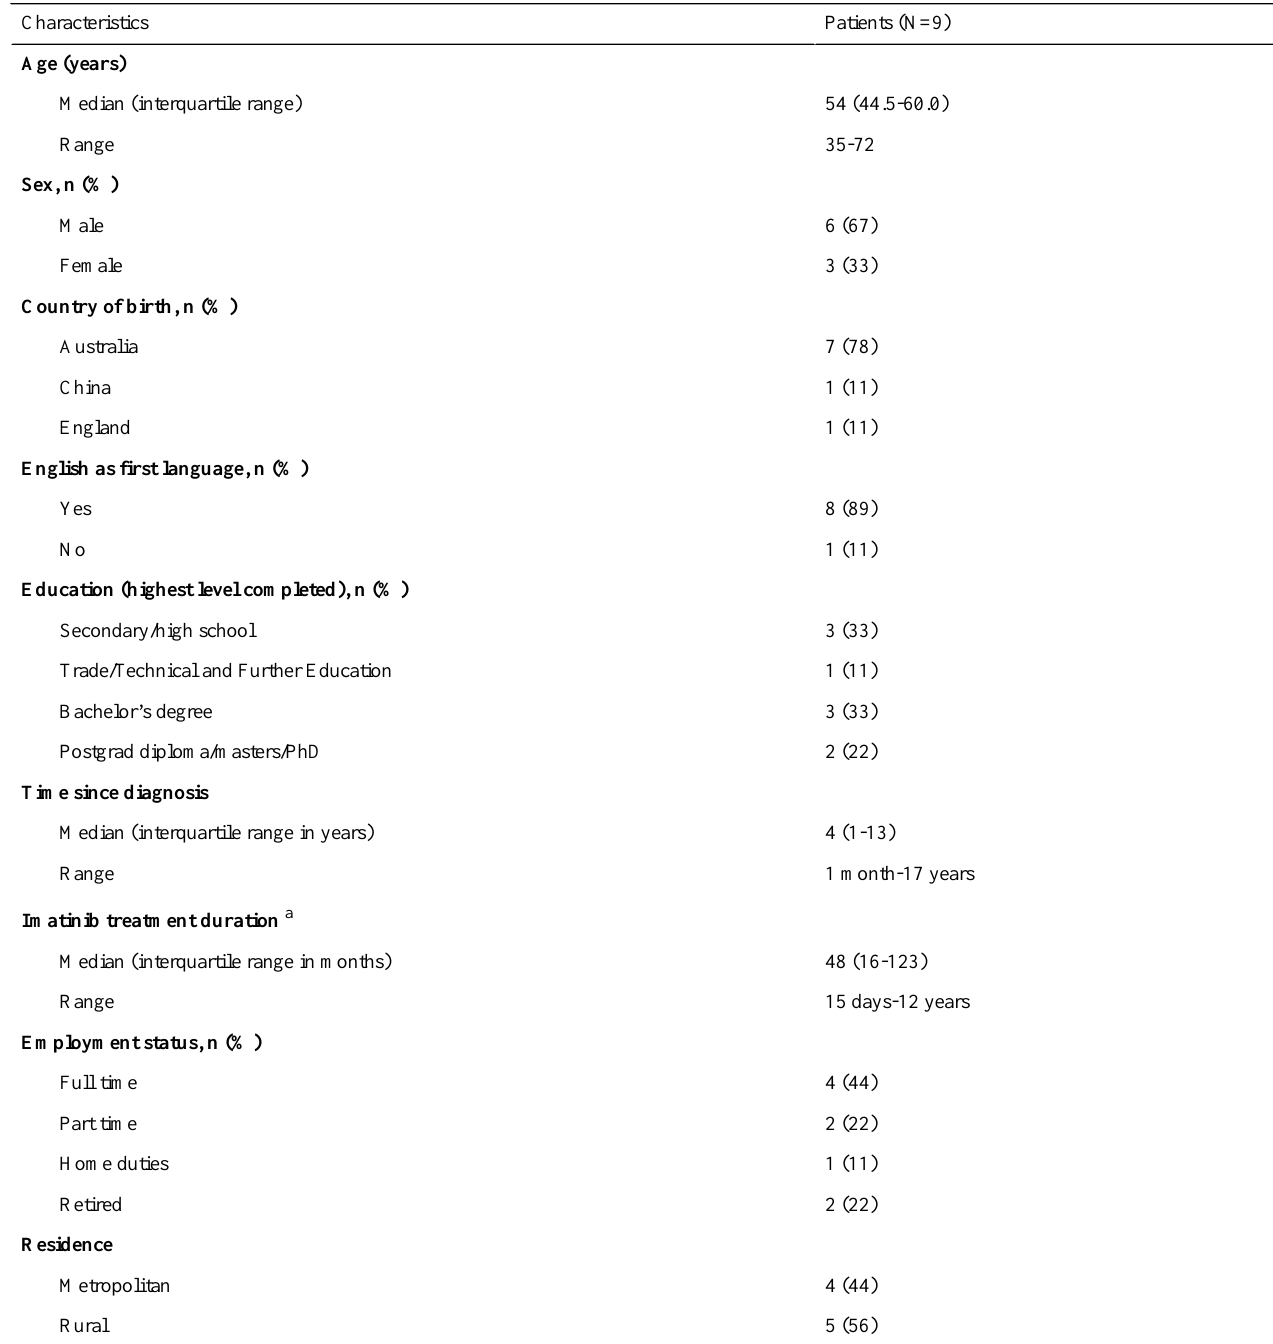
Table 1. Participant demographics.